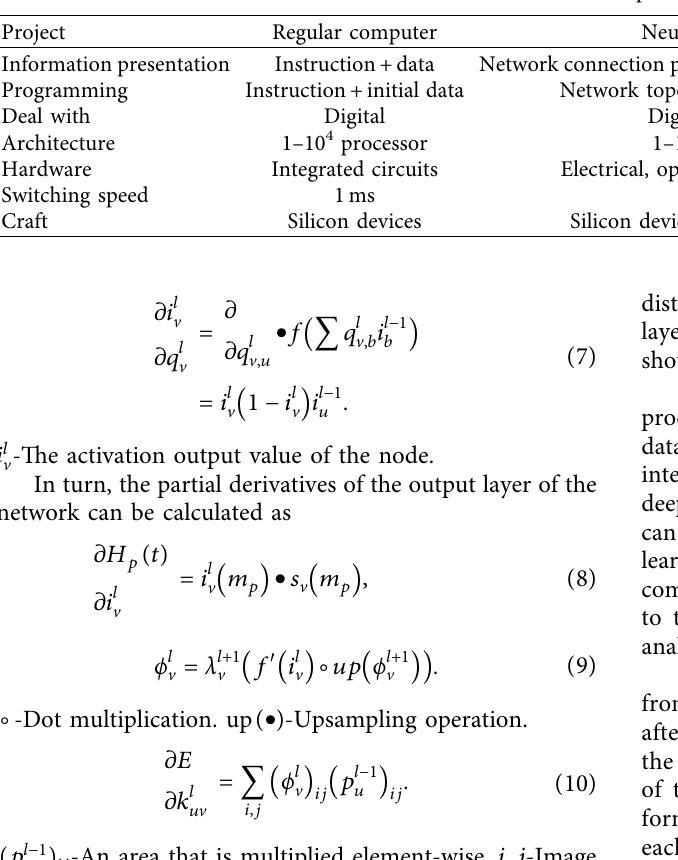
Table 1: Three information processing generic